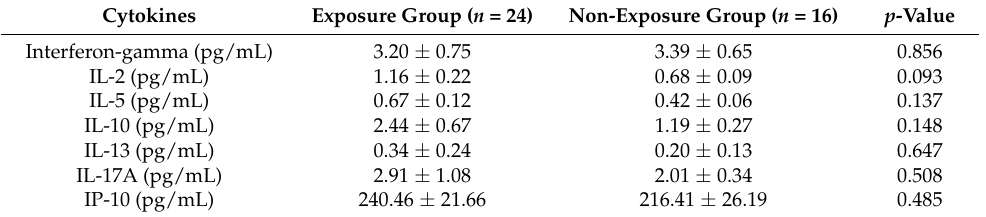
Table 2. The plasma levels of cytokines from patients with or without prenatal dexamethasone exposure. Cytokines